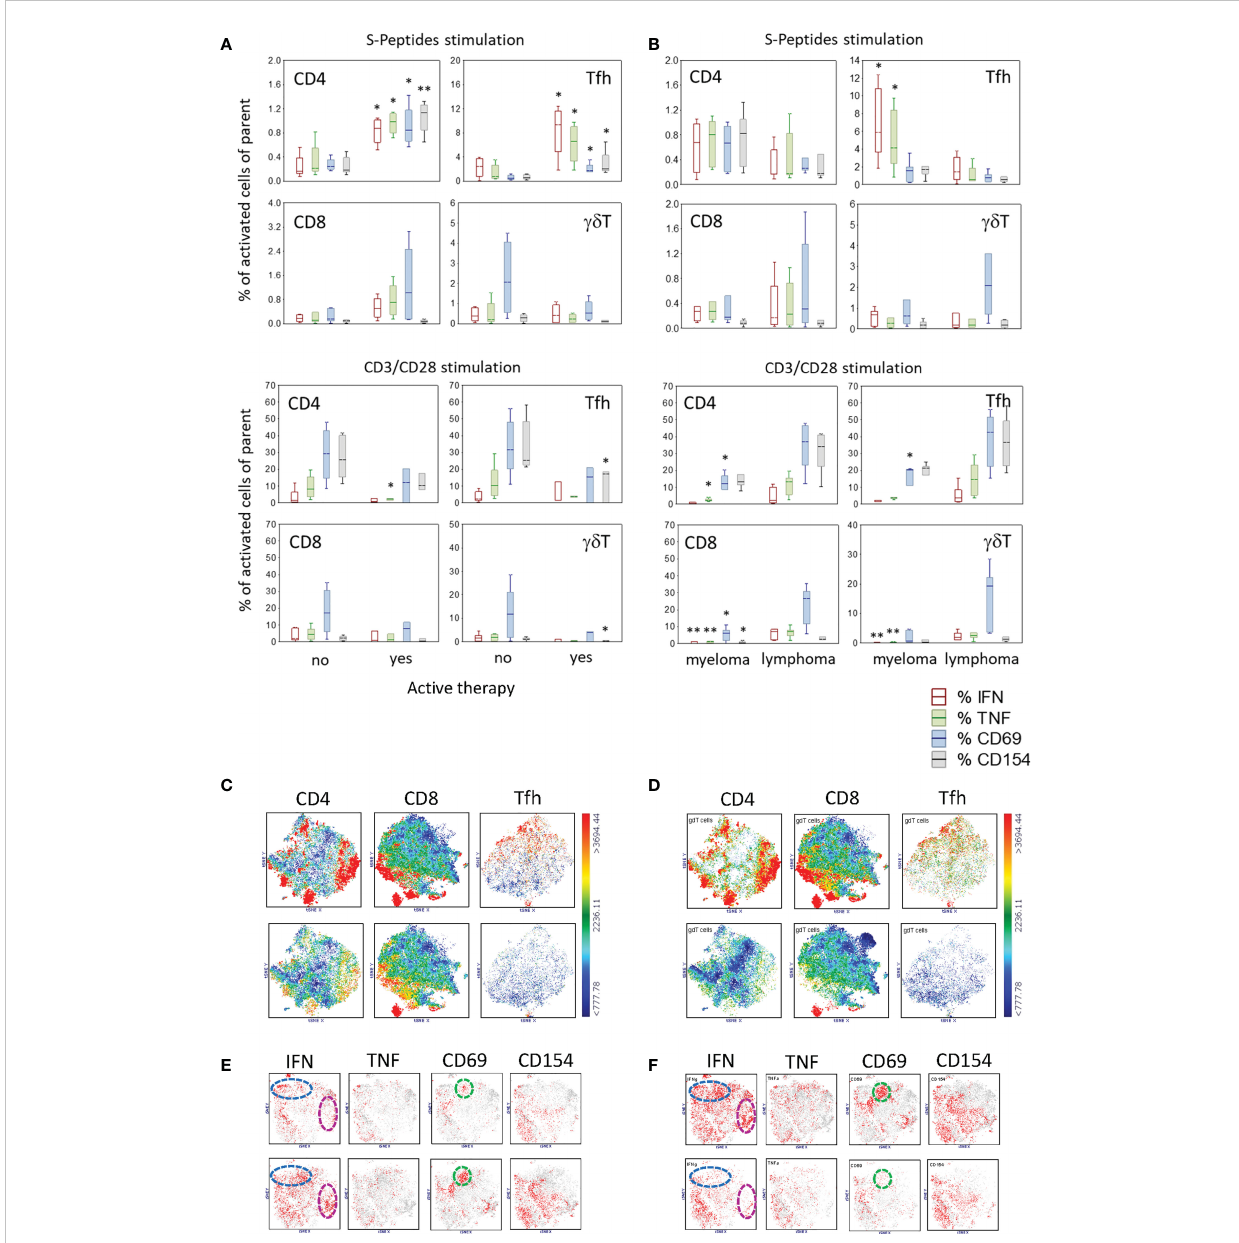
FIGURE 4 Activated T cell subtypes after S-Peptides or CD3/CD28 stimulation in samples of patients regarding (A) active therapy (no, N=8#, yes N=4) and (B) disease category (myeloma, N=6#, lymphoma, N=6) after two vaccine doses. Box plots with median, interquartile range and minimum-to-maximum whiskers show activated T cell subtypes as a percentage of the parent population (CD4, Tfh, CD8, gd T). Cells were identi fi ed after 6 h stimulation of PBMC and intracellular staining of cytokines (IFN, TNF) and activation markers (CD69, CD154) followed by fl ow cytometry. Active therapy means therapy before and during the vaccination period. Therapy started a minimum one month before 1st vaccination and ended more than one month after 2nd vaccination. Data analysis with Mann-Whitney U Test, *p<0.05, **p<0.005. Please note the different scaling for better visibility. # Due to the low blood amount, the CD3/CD28 stimulation analysis was not performed in one patient. (C) Distribution of gd T cells in the population of CD4, CD8 and Tfh cells as shown by tSNE analysis color-coded for the expression of gd TCR from blue (low) to red (high) in patients with no (top) and with active therapy (bottom) and similarly in (D) myeloma patients (top) and lymphoma patients (bottom) (E) t-SNE analysis of activation markers in gd T cells in patients with no (top) and with active therapy (bottom). (F) t-SNE analysis of activation markers in gd T cells in patients with myeloma (top) and with lymphoma (bottom). Color-coded from grey (<1000) to red (>1000) with dotted circles indicating the area of prominent t-SNE plot